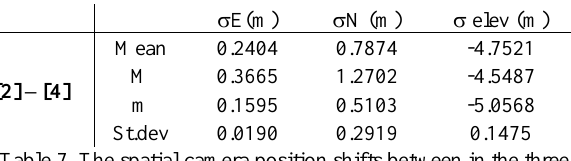
Table 7. The spatial camera position shifts between in the